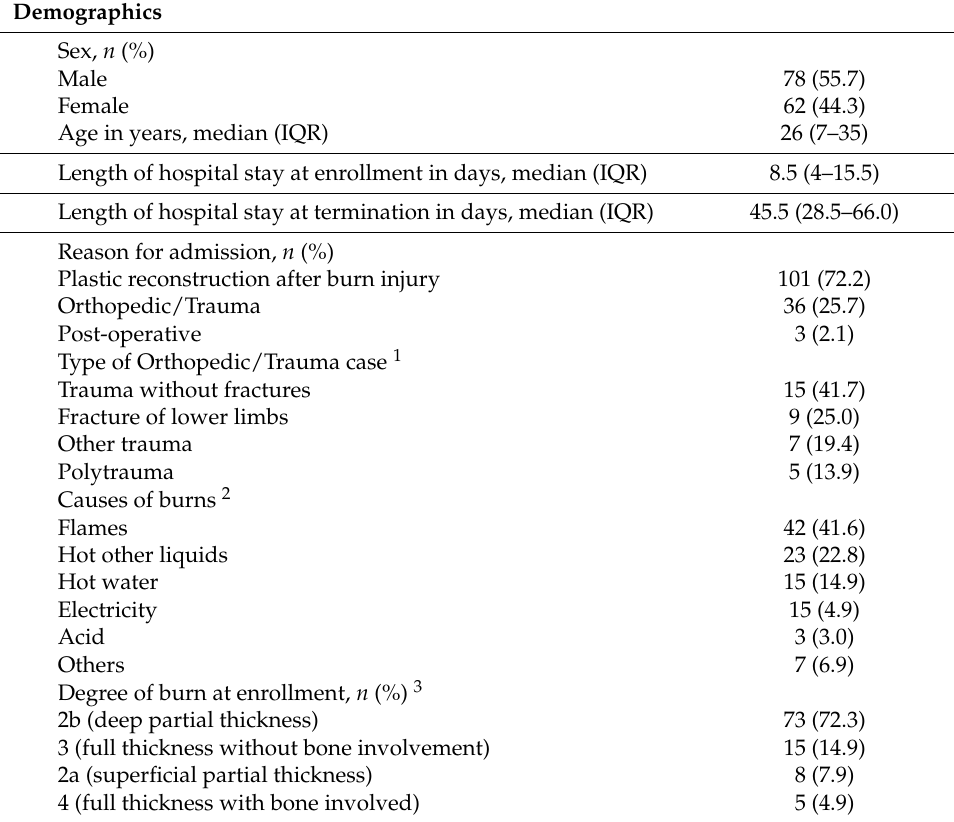
Table legend: IQR = inter-quartile range. 1 Denominator is the number of patients with orthopedic/trauma as the reason for admission ( n = 36). 2 Multiple causes of burns in one patient possible. 3 Denominator is the number of patients admitted due to a burn injury ( n =